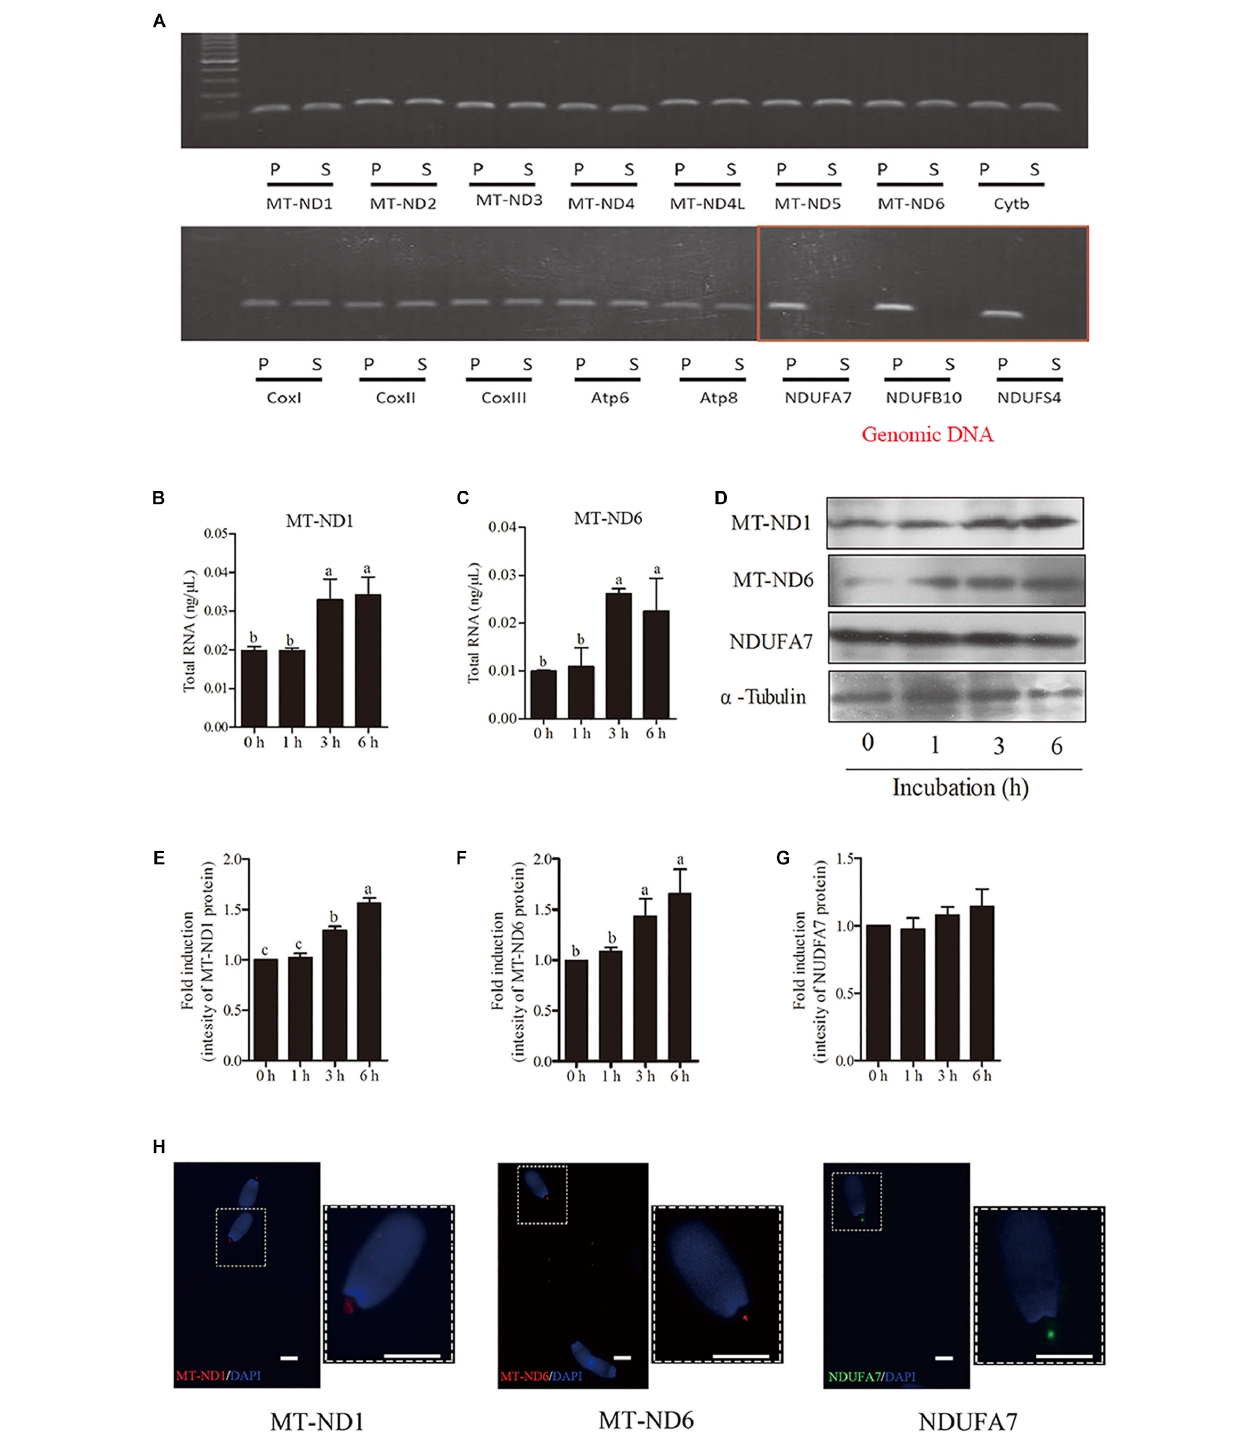
FIGURE 3 | The transcription and translation in sperm mitochondria. (A) RT-PCR derived expression of mitochondrial and nuclear genes, where – S, boar sperm; P, positive control (porcine ovarian granulosa cell). (B,C) Time-dependent changes in the expression of mt-Nd1 (B) and mt-Nd6 (C) genes during 6 h incubation. (D) Western blotting image showing the expression of the mitochondria-encoded protein (MT-ND1 and MT-ND6), nuclear-encoded protein (NDUFA7), and α -tubulin during 6 h incubation. (E–G) Quantitative expression of the MT-ND1, MT-ND6, and NDUFA7 over α -tubulin (control) generated from western blotting. (H) Immunolocalizations of MT-ND1, MT-ND6, and NDUFA7 in boar sperm, scale bar indicates 5 µ m. Values are specified as mean ± SEM of three replicates. Columns with different lowercase letters differ significantly ( p < 0.05).